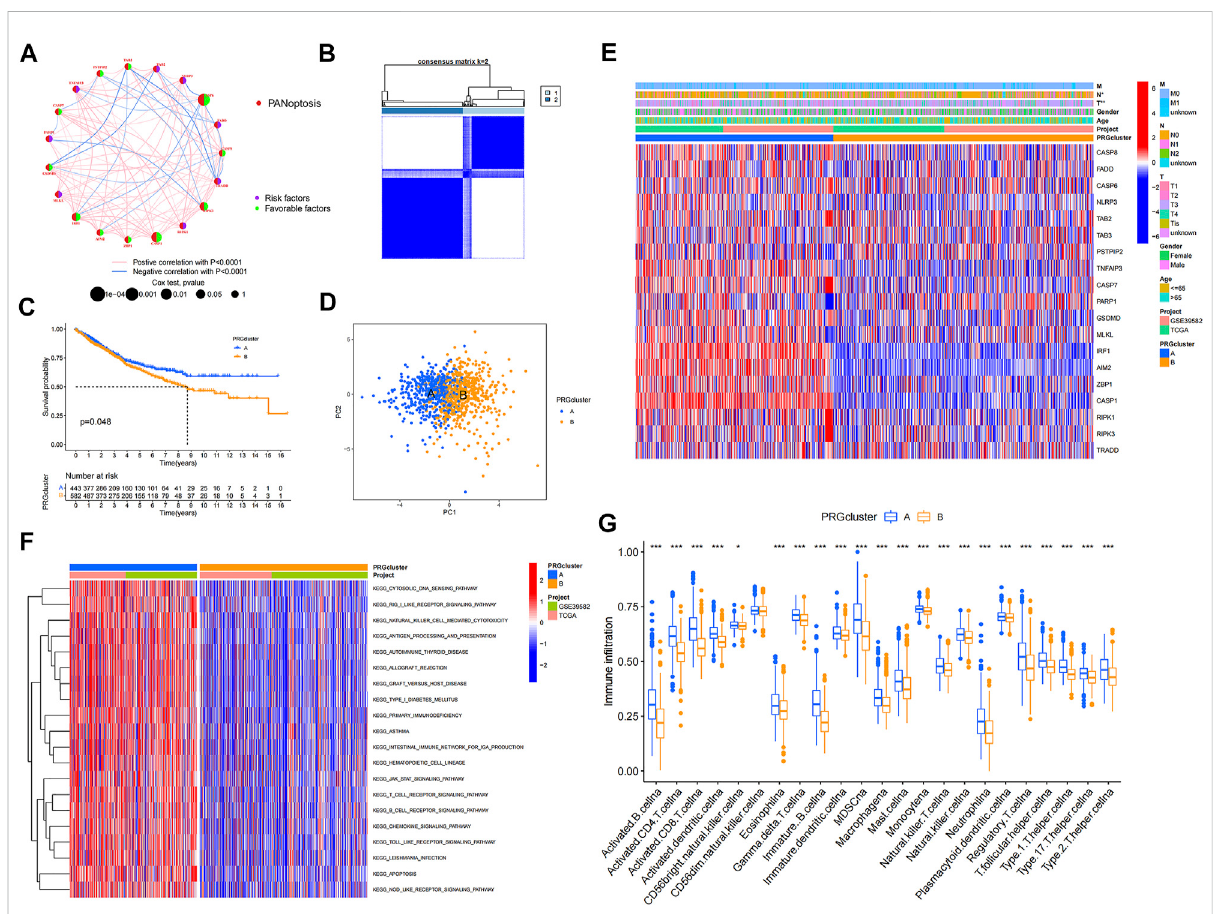
FIGURE 2 PRGclusters and clinical characteristics between colon cancer samples in two clusters. Relationship of tumor microenvironment in two PRGclusters. (A) Interactions among PRGs in colon cancer. The lines among the PRGs represents their interactions. Blue and red represent negative and positive correlations. (B) Two PRGclusters were de fi ned using consensus clustering analyses. (C) KM curve indicated that PRGcluster a had longer survival time than PRGcluster B ( p = 0.048). (D) PCA showed good distiction between two PRGclusters. (E) Heatmaps showed the relationship between PRGclusters and clinical features and PRGs expression in colon cancer patients. (F) GSVA showed the enriched pathways in PRGclusters. (G) ssGSEA investigated the differences of immune cell in fi ltration between two clusters. * p < 0.05; ** p <